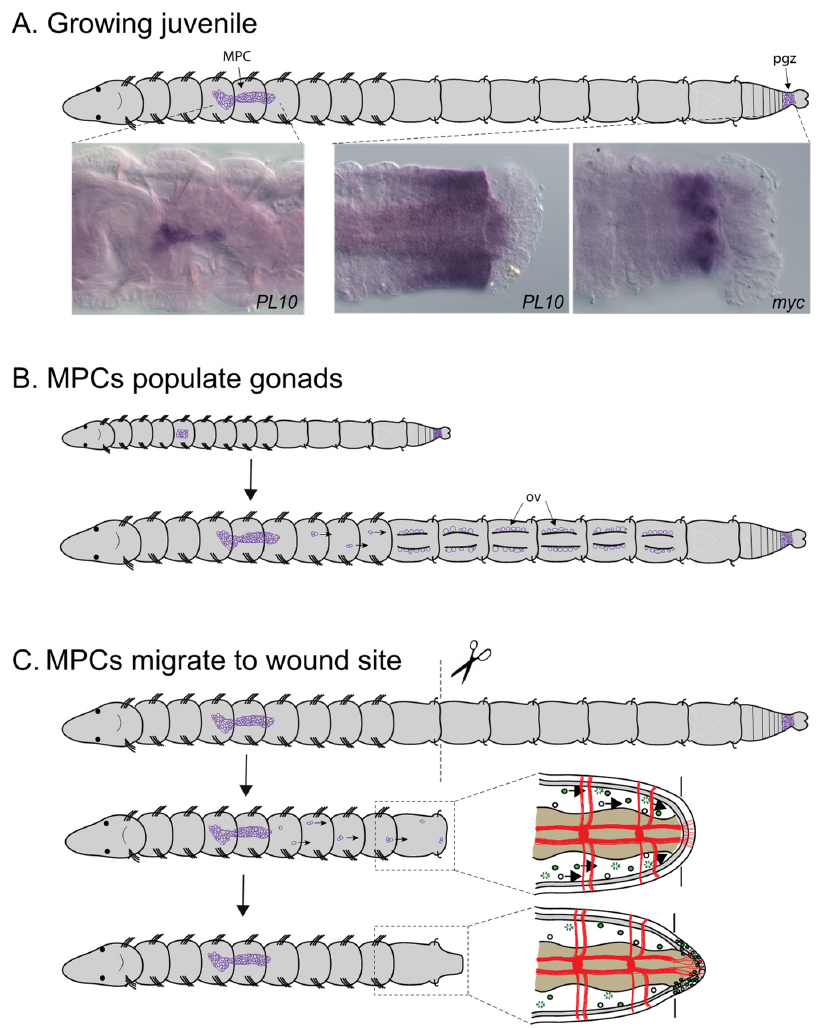
Figure 8. Hypothesized roles for MPC cluster in Capitella . All images are oriented with anterior to the left and in ventral view. ( A ) Schematic of juvenile worm showing location of MPC cluster (MPC) and posterior growth zone (pgz), two domains that express somatic/germline stem cell markers (purple). High magnification inset images show gene expression of PL10 in the MPC cluster and posterior growth zone and myc in the posterior growth zone. Purple precipitate indicates mRNA localization using whole mount in situ hybridization. Dotted lines indicate enlarged area of body shown for gene expression patterns. ( B ) Working model for role of MPCs in populating gonads with germ cells. As the ovaries mature, cells from the MPC cluster migrate (arrows in bottom schematic) several segments to reach the ovaries, which are located in the abdominal segments. ( C ) Working model of MPC response during regeneration. Amputation initiates a signal from the wound site. Cells from the MPC respond by migrating towards the wound site (arrows in center images). Migrating and locally derived cells populate the blastema and contribute to its growth (bottom images). Top, uncut animal; middle, animal soon after amputation; bottom, amputated animal after blastema has formed. Dotted line boxes indicate area of detail shown to right for middle and bottom images. Top schematic, young juvenile worm. Bottom schematic, older individual with ovaries that contain immature oocytes. Abbreviations: ov, ovary; MPC, multipotent stem cell cluster; pgz,